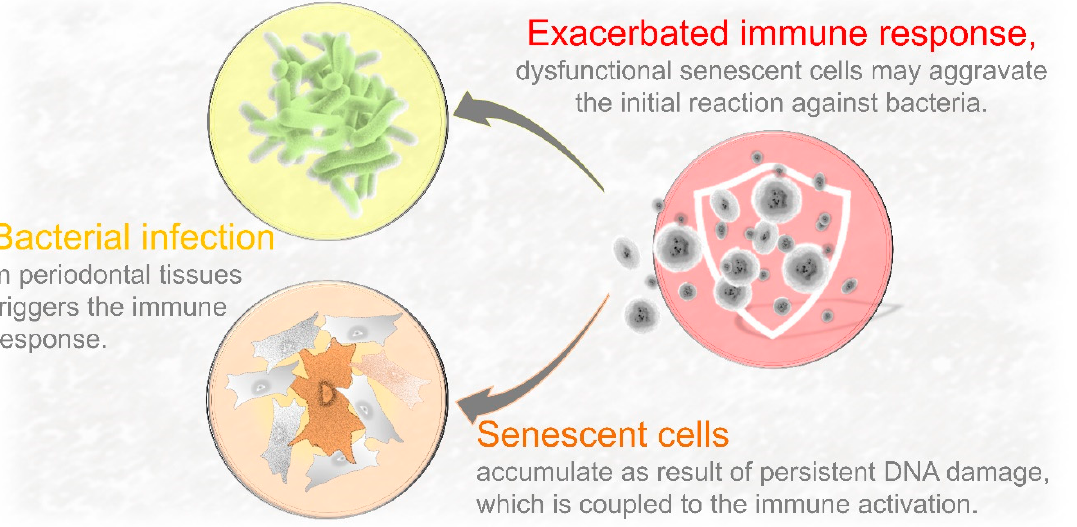
Figure 3. Potential mechanism by which senescent cells aggravate periodontal tissue deterioration. Cells that survive persistent DNA damage acquire a senescent phenotype, which is characterized by the hypersecretion of key proinflammatory cytokines. DNA damage-driven senescence is a crucial intermediate mechanism between DNA damage and host immune activation. Released factors by these dysfunctional cells could aggravate the initial immune reaction against pathogenic bacteria. Thus, gradual accumulation of senescent cells in periodontal tissues during lifetime could contribute to the progression of periodontal tissue deterioration.